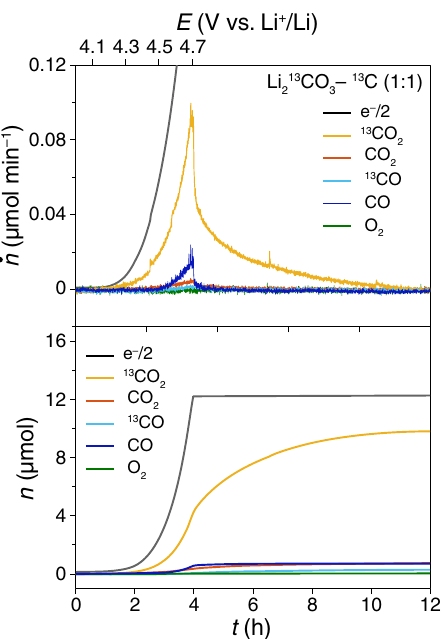
Fig. 4 | The gas evolution of the electrolyte decomposition. The gas evolution during the charging process of the cells using Li 2 13 CO 3 - 13 C-carbon (1:1) composite electrodein1MLiTFSI-tetraglyme.Ar fl owrate:0.5mLmin − 1 .Sweeprate:0.05mVs − 1 . The molar fl ux (top panel) of gas evolution was denoted as ṅ and the charging current is translated to ṅ electron and the cumulative mole (bottom panel) of the gas was denoted as n . The unlabeled CO 2 and CO are contributed by electrolyte